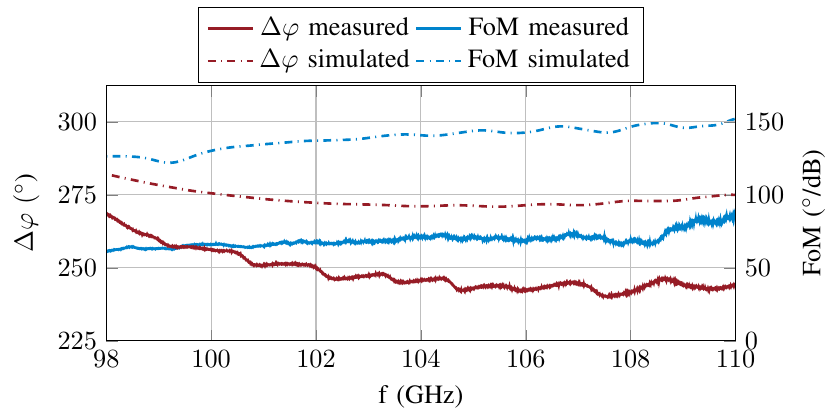
Figure 27. Simulated and measured differential phase shift and FoM of the NRD LC phase